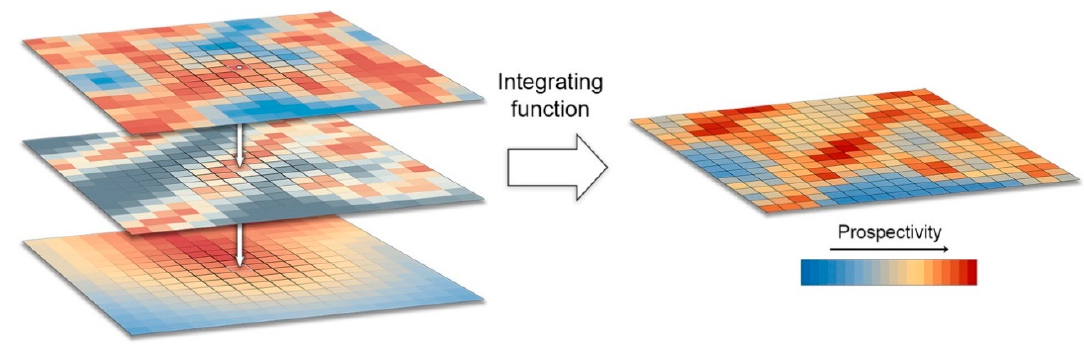
Figure 6. Combining evidential layers with raster maths. Weights assigned to predictor map features are converted into pixel values during rasterisation. A variety of integrating functions can then be used to combine the rasterised evidential layers. This commonly involves performing mathematical operations between geographically aligned pixels, resulting in a numerical grid of values that represent relative prospectivity.